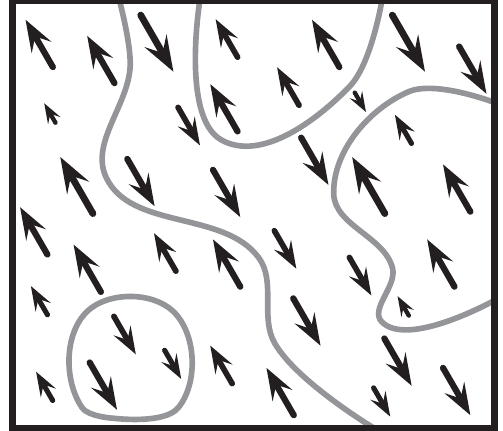
space.FIG. 1. Magnetic moments in the ground state of the SDW glass. The disorder pins the domain walls into a random configuration, but the structure of “ antiphase ” domain walls persists. Upon crossing of each domain wall, the local magneti- zation changes sign. Thus, the disordered state inherits the collinear structure from the parent SDW, where the axis along which the moments point is selected spontaneously, breaking the spin-rotation